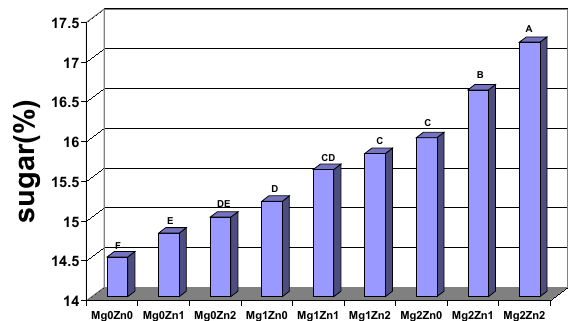
Fig. 3. Effects of Mg and Zn on the sugar percentage in